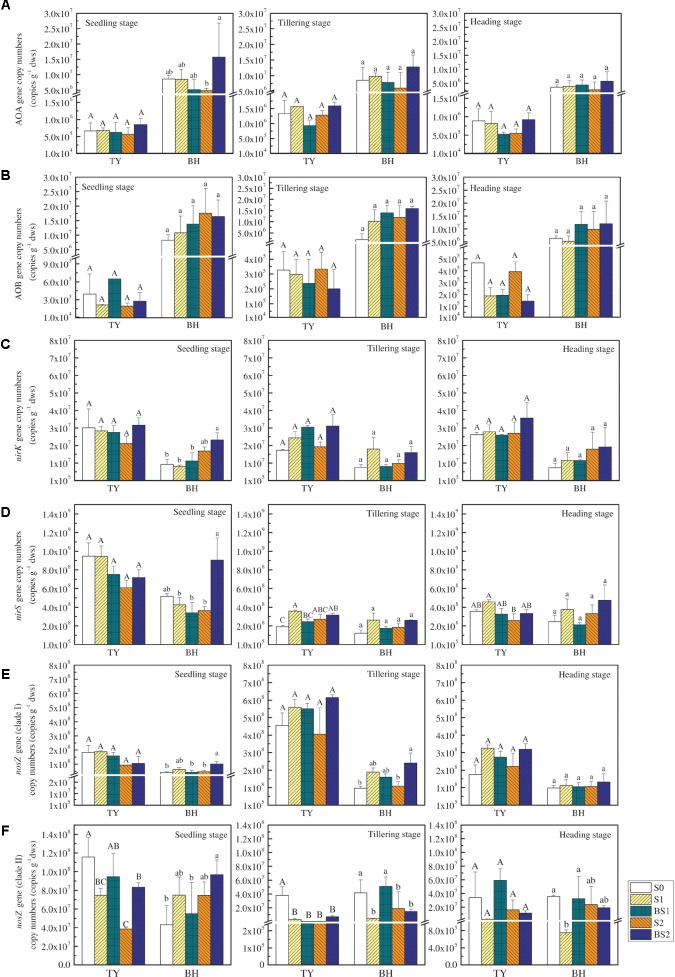
The abundance of N2O-related functional genes at the seedling, tillering and heading stages in 2016. The copy numbers of archaeal amoA, bacteria amoA, nirK, nirS, nosZ I, and nosZ II genes are exhibited in (A–F), respectively. Error bars present standard deviations of means (n = 3). The different letters (capital letter for the TY soil and lowercase for the BH soil) indicate significant difference among different treatments at each sampling point, which was analyzed by Duncan’s multiple range test (P < 0.05).